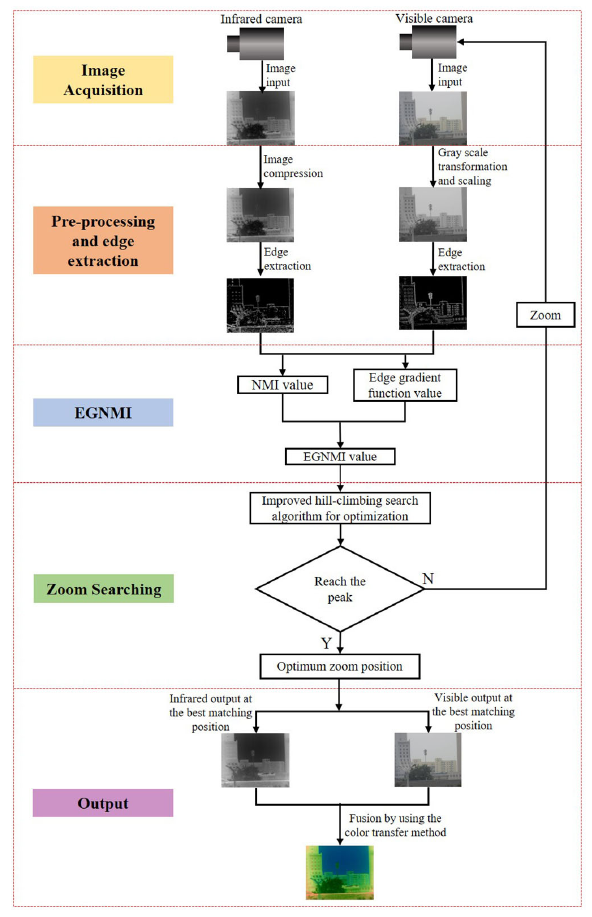
Figure 2. Mismatch adjustment fl owchart.